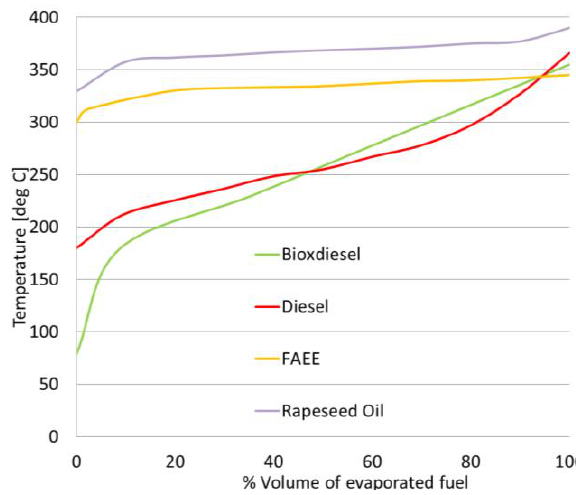
Fig. 2. Evaporation curves for Diesel, FAEE, raw rapeseed oil and Bioxdiesel